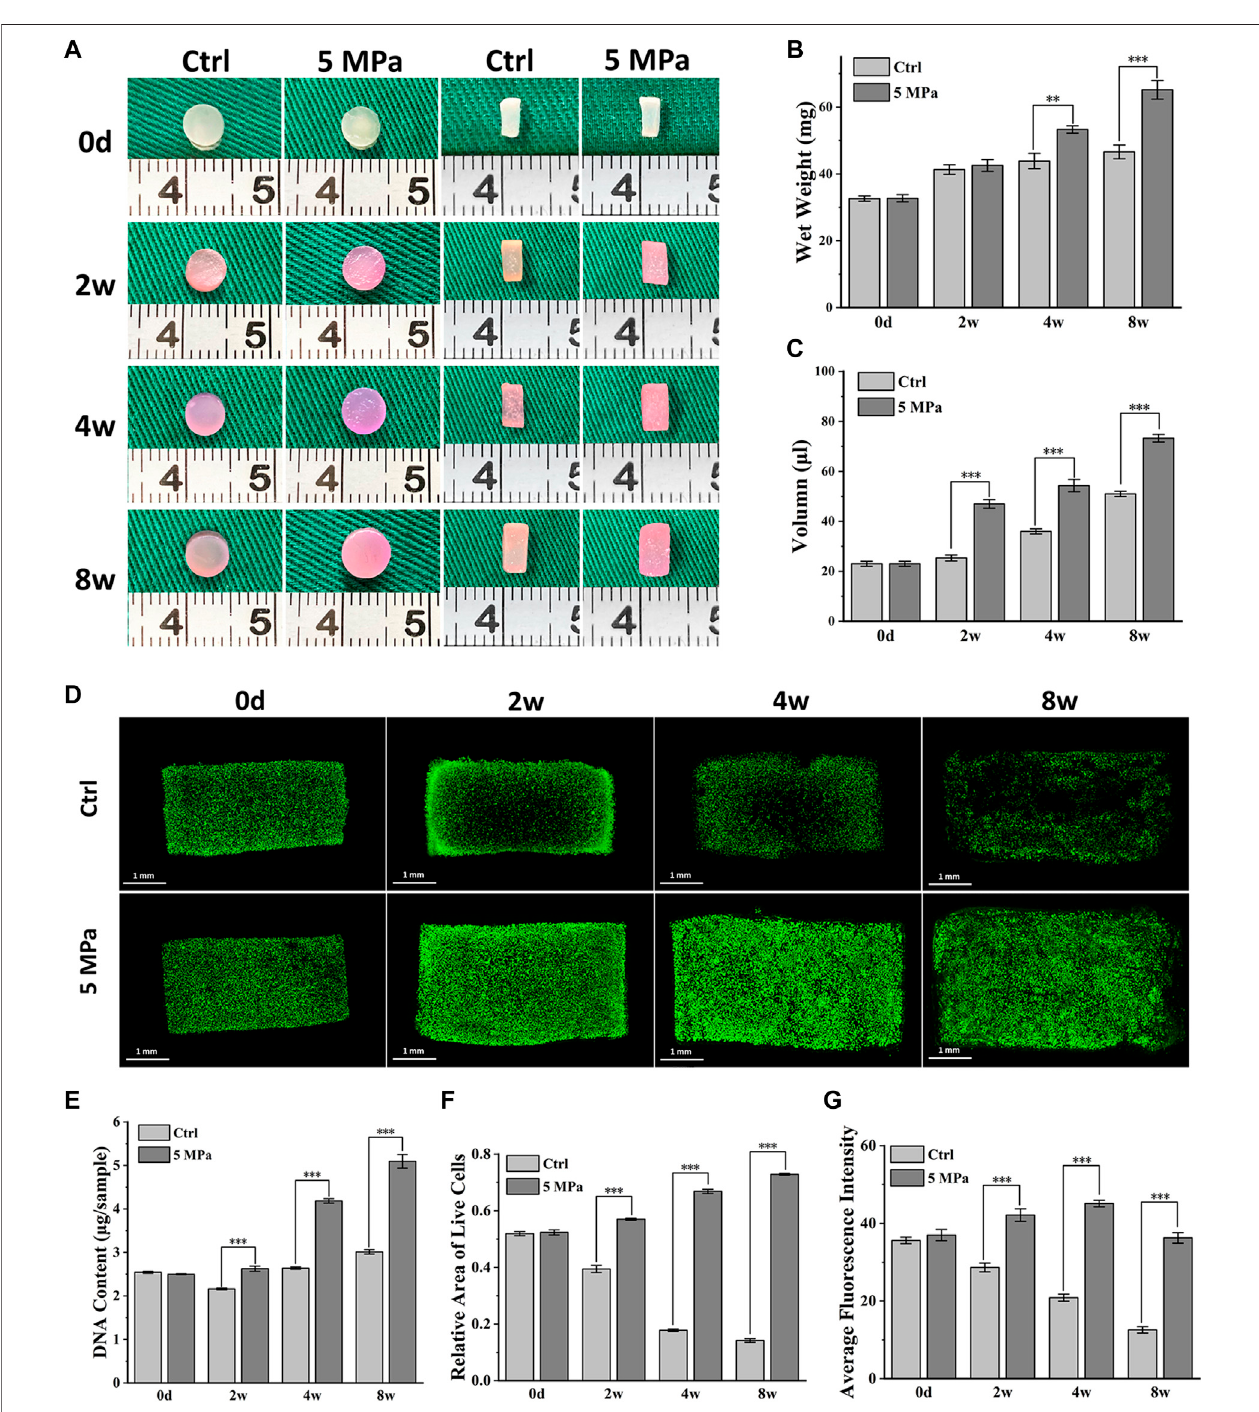
FIGURE3| BiologicalbehaviorevaluationofchondrocytesmediatedbyHP. (A) FrontandlongitudinalsectionviewofCHPCcultured invitro . (B – C) Thewetweight (B) and volume (C) ( p < 0.05) of CHPC cultured in vitro . (D) Live and dead cell staining of CHPC cultured in vitro . (E) DNA quanti fi cation ( p < 0.001) of CHPC cultured in vitro . (F – G) The relative area of live cells (F) and the average fl uorescence intensity (G) ( p < 0.001), the semi-quantitation results of Figure 3D .